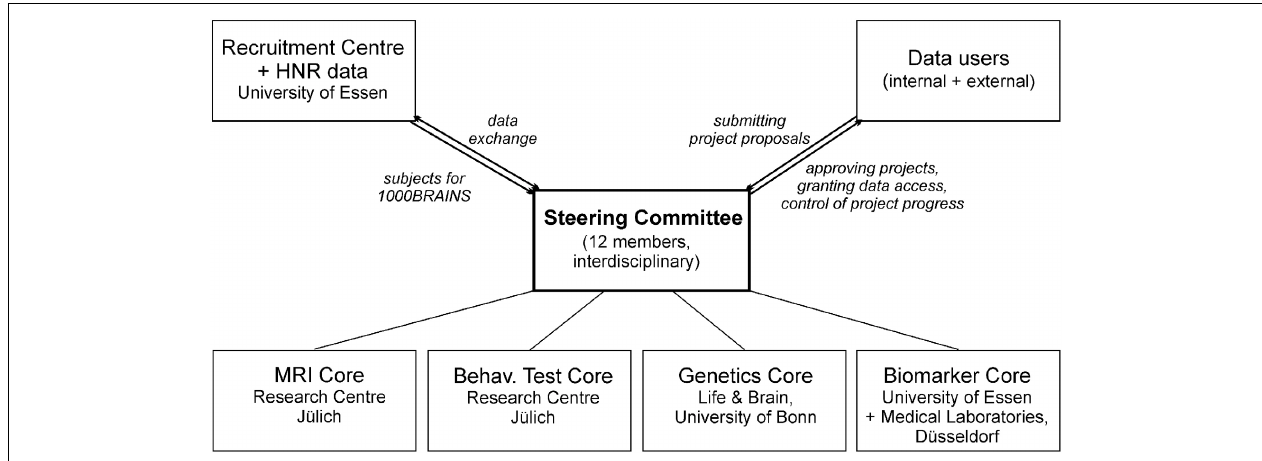
FIGURE 4 | Management and organizational structure of the 1000BRAINS